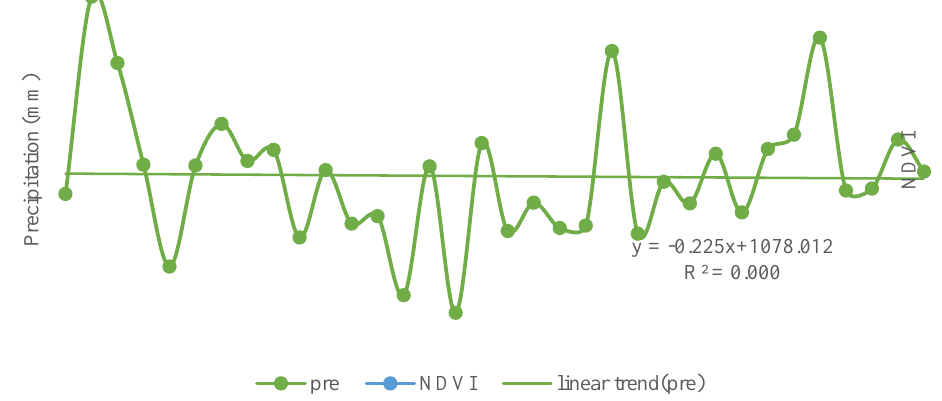
Figure 10. Variation curve of NDVI and annual mean precipitationin Shaanxi Province during 1982– 2015 (“pre” denotes the precipitation. The x -axis represents the year.). Table 4. The relationships between NDVI metrics and climate factors (sos: start of season, sos: end of season. *** p < 0.001; ** p < 0.05; * p < 0.1).